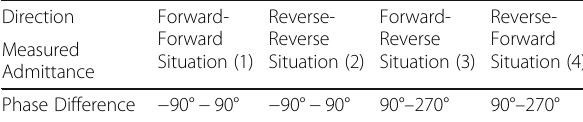
Table 1 Phase difference change information of